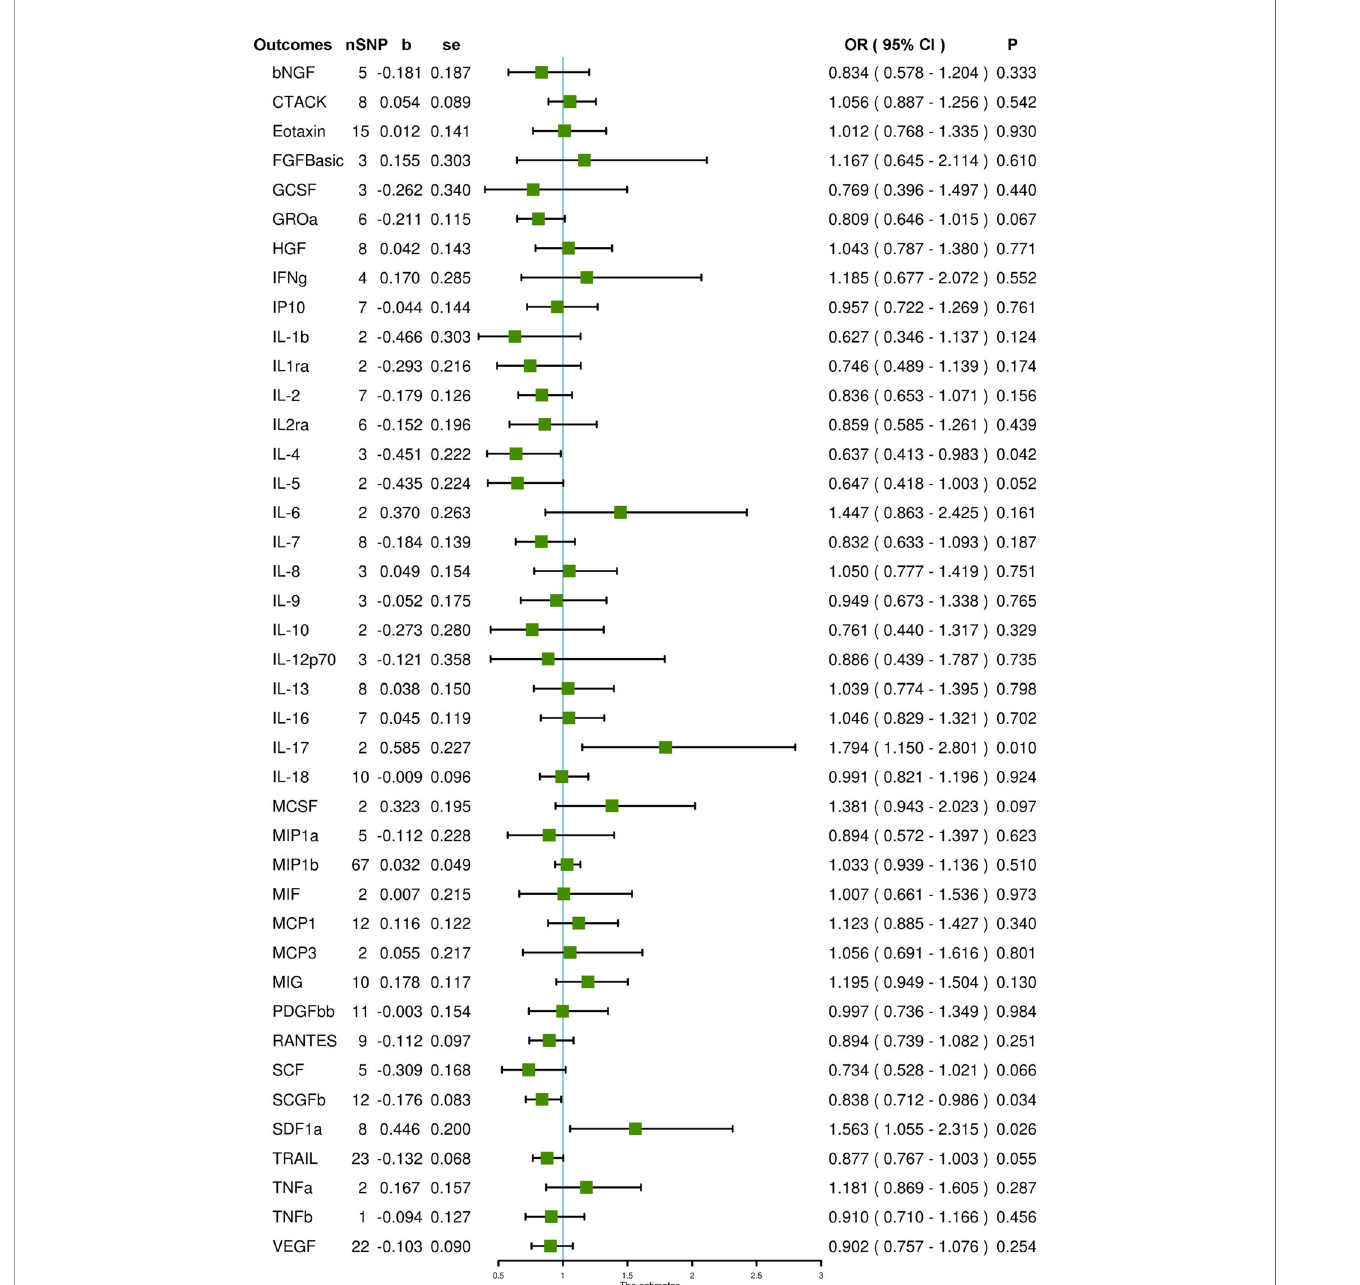
FIGURE 2 | The association of systemic in fl ammatory regulators with PCOS using SNPs reaching the P<5×10 – 6 signi fi cance level: the inverse-variance weighted (IVW) method was applied as the primary method for MR analysis. SNP, single nucleotide polymorphism; b, beta coef fi cient; se, standard error; OR, odds ratio; CI, con fi dence interval; MR-PRESSO, Mendelian randomization pleiotropy residual sum and outlier; bNGF, beta-nerve growth factor; CTACK, cutaneous T-cell attracting chemokine; FGFBasic, fi broblast growth factor basic; GCSF, granulocyte-colony stimulating factor; GROa, growth-regulated protein alpha; HGF, hepatocyte growth factor; IFNg, interferon gamma; IP10, interferon gamma-induced protein 10; IL-1b, interleukin-1-beta; IL1ra, interleukin-1-receptor antagonist; IL-2, interleukin-2; IL2ra, interleukin-2 receptor antagonist; IL-4, interleukin-4; IL-5, interleukin-5; IL-6, interleukin-6; IL-7, interleukin-7; IL-8, interleukin-8; IL-9, interleukin-9; IL-10, interleukin-10; IL-12p70, interleukin-12p70; IL-13, interleukin-13; IL-16, interleukin-16; IL-17, interleukin-17; IL-18, interleukin-18; MCSF, macrophage colony stimulating factor; MIP1a, macrophage in fl ammatory protein 1a; MIP1b, macrophage in fl ammatory protein 1b; MIF, macrophage migration inhibitory factor; MCP1, monocyte chemoattractant protein-1; MCP3, monocyte chemoattractant protein-3; MIG, monokine induced by gamma interferon; PDGFbb, platelet-derived growth factor BB; RANTES, regulated on activation, normal T cell expressed and secreted; SCF, stem cell factor; SCGFb, stem cell growth factor beta; SDF1a, stromal-cell- derived factor 1 alpha; TRAIL, TNF-related apoptosis-inducing ligand; TNFa, tumor necrosis factor alpha; TNFb, tumor necrosis factor beta; VEGF, vascular endothelial growth factor.